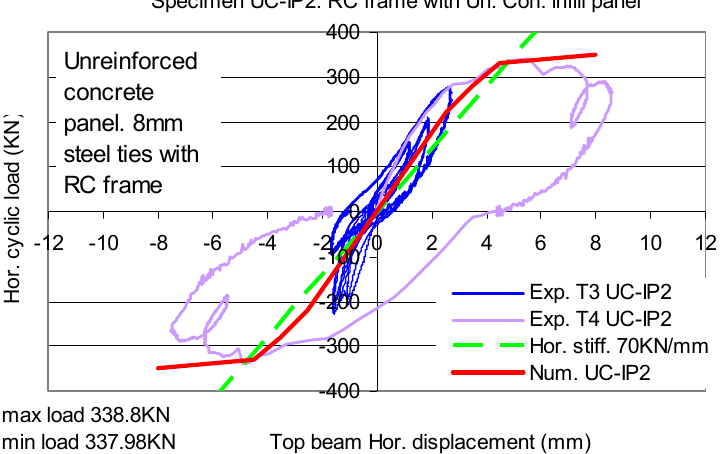
Figure 24. Horizontal displacement versus horizontal load cyclic response of specimen UC-IP 2. Comparison between observed and numerically predicted behaviour.